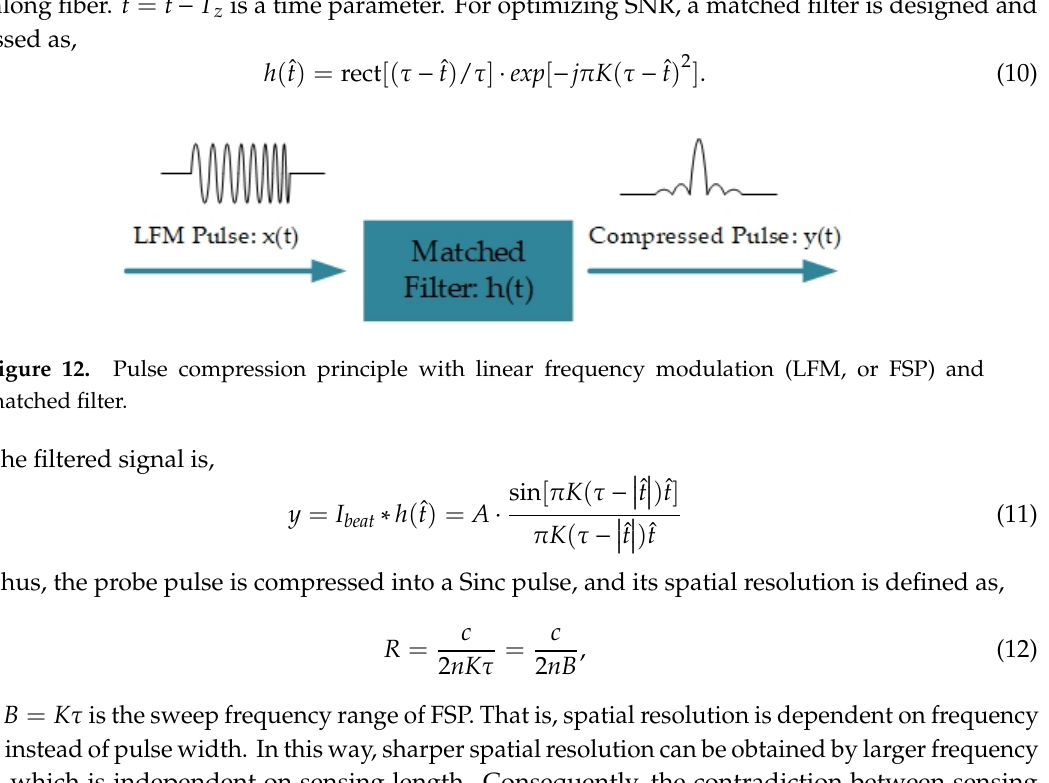
Figure 14. Experimental results with ( a ) one PZT and ( b ) two PZTs. Reproduced with permission from our previous paper [22], published by Optical Society of America, 2017 . 3.5. Distributed Multi-Dimension Localization In DAS, disturbance localization is achieved by the flight time of the probe laser along the sensing fiber in time or frequency domain (OTDR or OFDR), and only a one-dimension position is obtained in the fiber axial dimension, as shown in Figure 15a. The relative position between disturbance source and sensing fiber is hard to obtain. For clarity, the difference among multi- dimension positions is shown in Figure 15b. The absence of multi-dimension spatial position information limits the performance and applications of DAS, including, perimeter security, railway